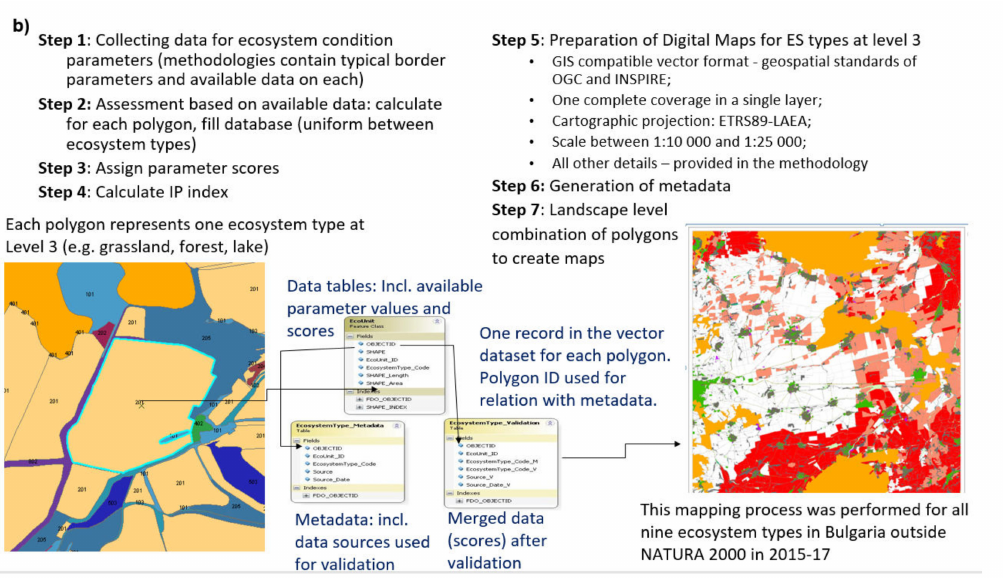
Figure 4. Data fusion, processing and integration into workflows: ( a ) Example of cross-ecosystem comparison of indicators by semi-quantitative parameter assessment (here, the key biodiversity indicators for plants for the ecosystem types presented in our study area); ( b ) workflow of a landscape level assessment, standard database structure and results for mapping and